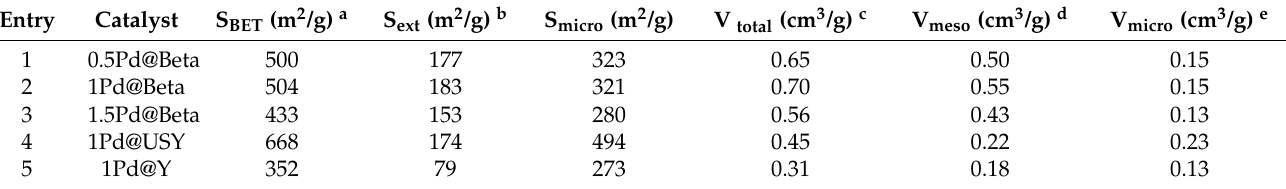
Table 1. Physico-chemical characterization of the catalytic